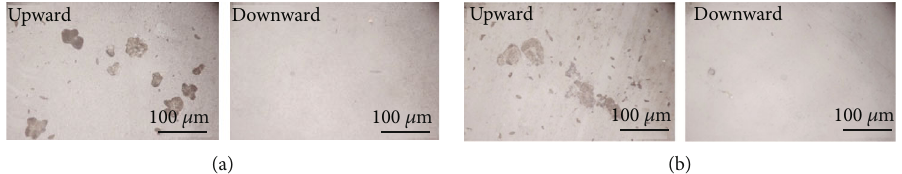
Figure 5: Optical microscope images of the (a) PMMA and (b) glass substrates on the downward and upward systems after 20 months of exposure (May 24,